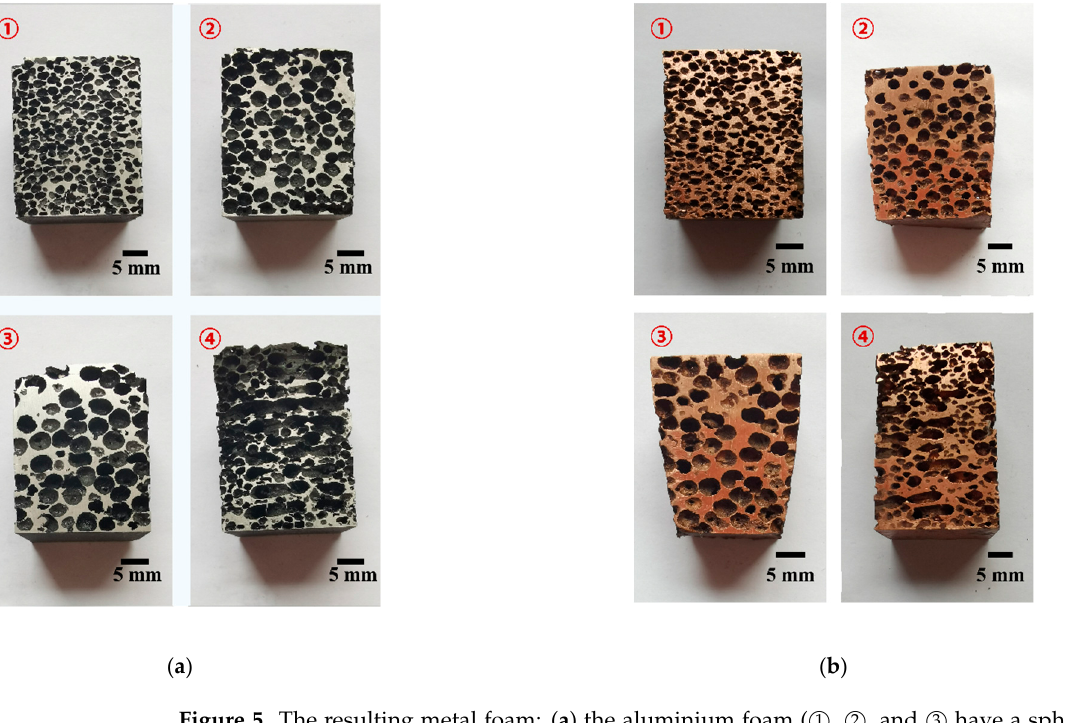
Table 2. Actual porosity p of foam